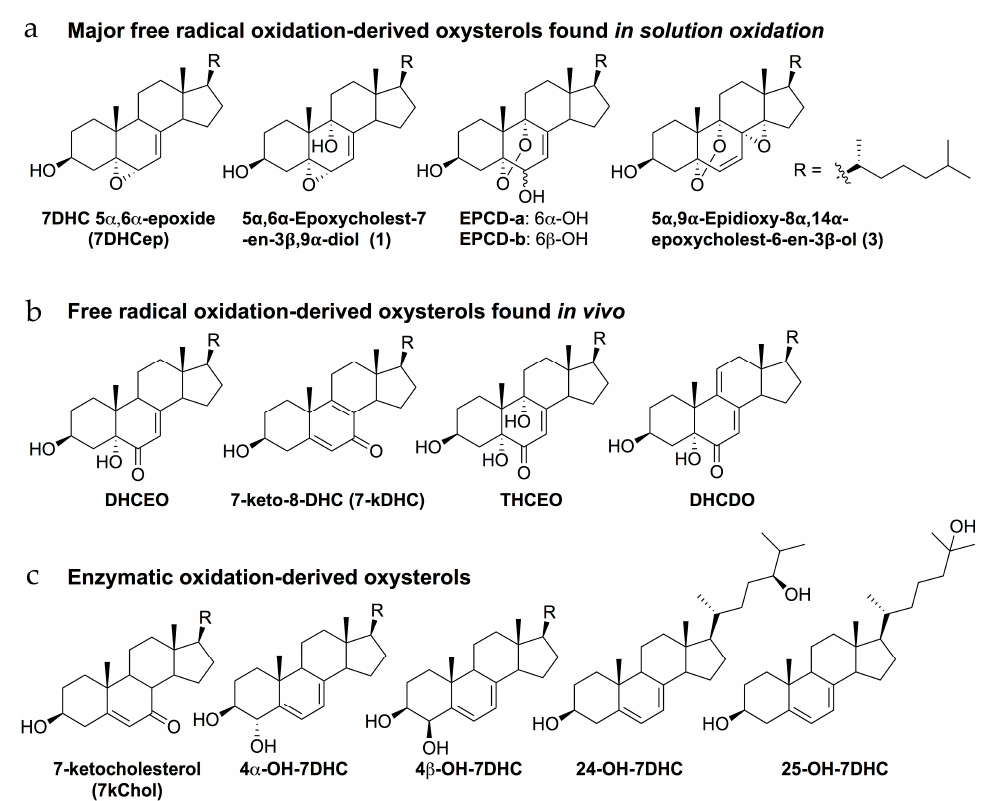
Figure 3. Chemical structure of some 7DHC-derived oxysterols: ( a ) Major oxysterols derived from free radical oxidation of 7DHC in organic solvent (benzene); ( b ) Oxysterols metabolites observed in biological systems that are derived from the primary oxysterols in solution; ( c ) Oxysterols derived from enzymatic oxidation of 7DHC by cytochrome P450 (CYP).